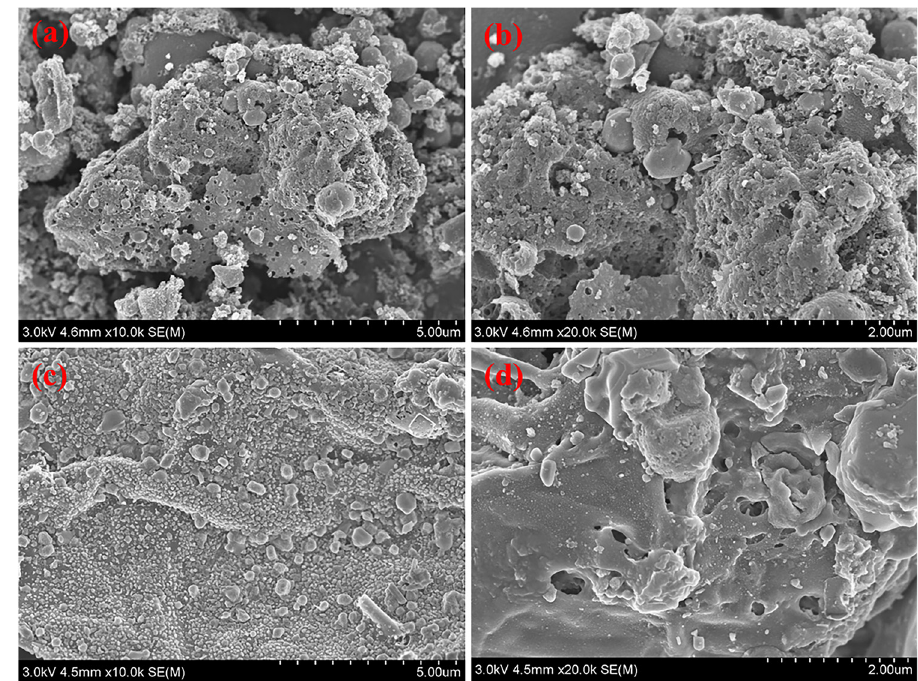
Figure 4: ( a and b ) SEM of Biochar; ( c and d ) SEM of AF - biochar.